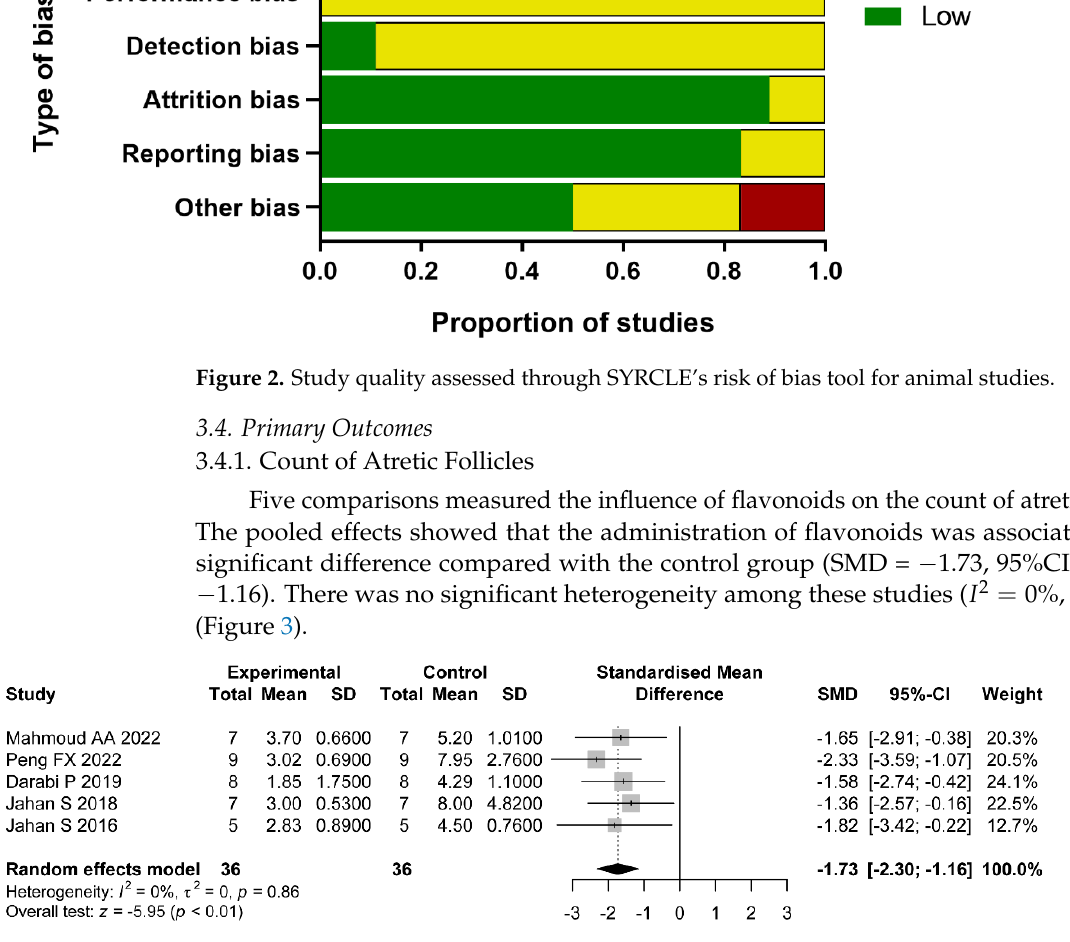
Figure 3. Forest plot of flavonoids for the count of atretic follicles.